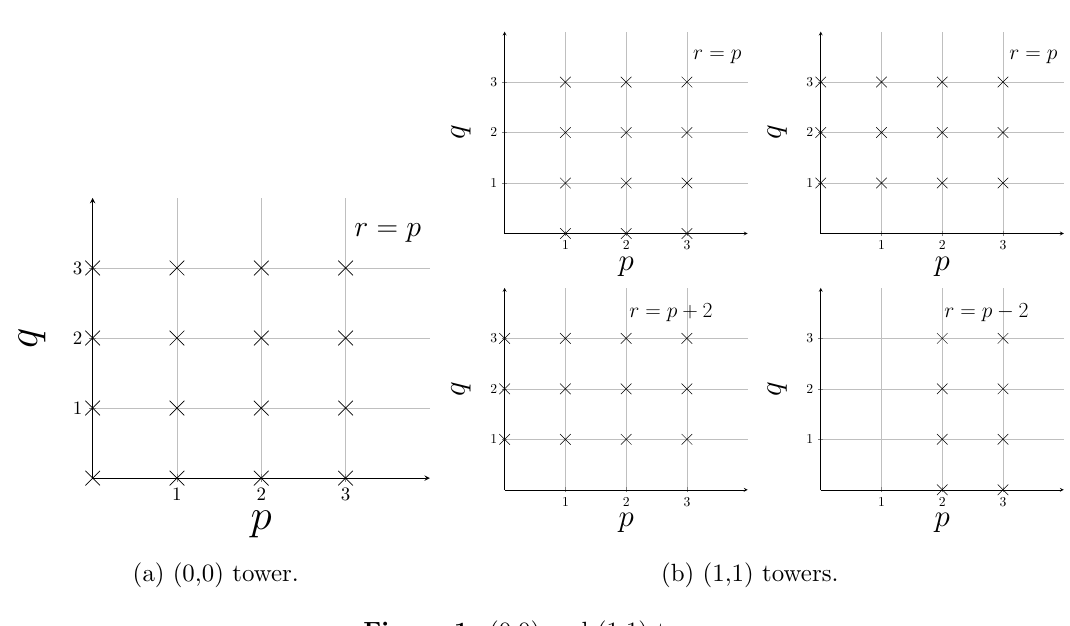
Figure 1. (0,0) and (1,1)